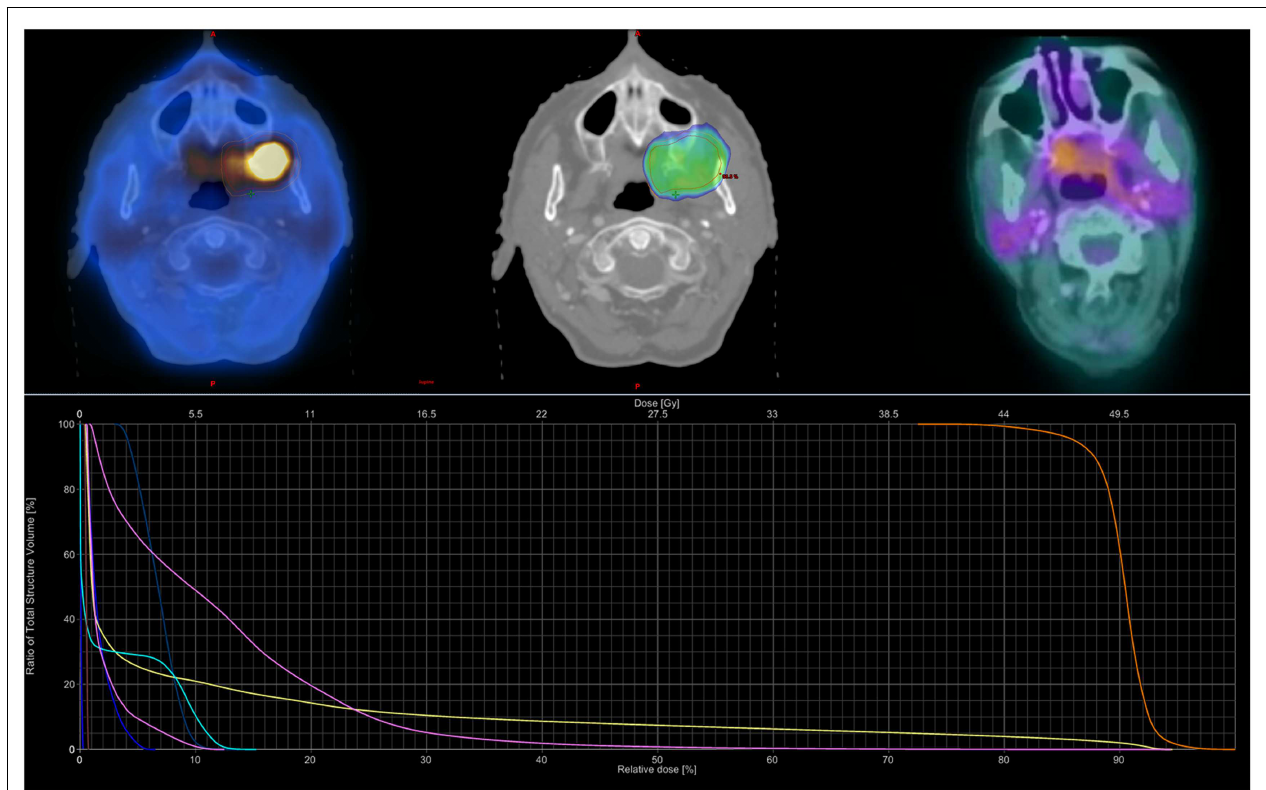
cavity (pink), mandible (yellow), spinal cord (chartreuse), and parotids (right dark blue, left blue-green). She completed therapy with but grade 1 mucositis; she later developed grade II oral ulceration and trismus. She remained NED with complete metabolic response until dying from co-morbidities 20months following